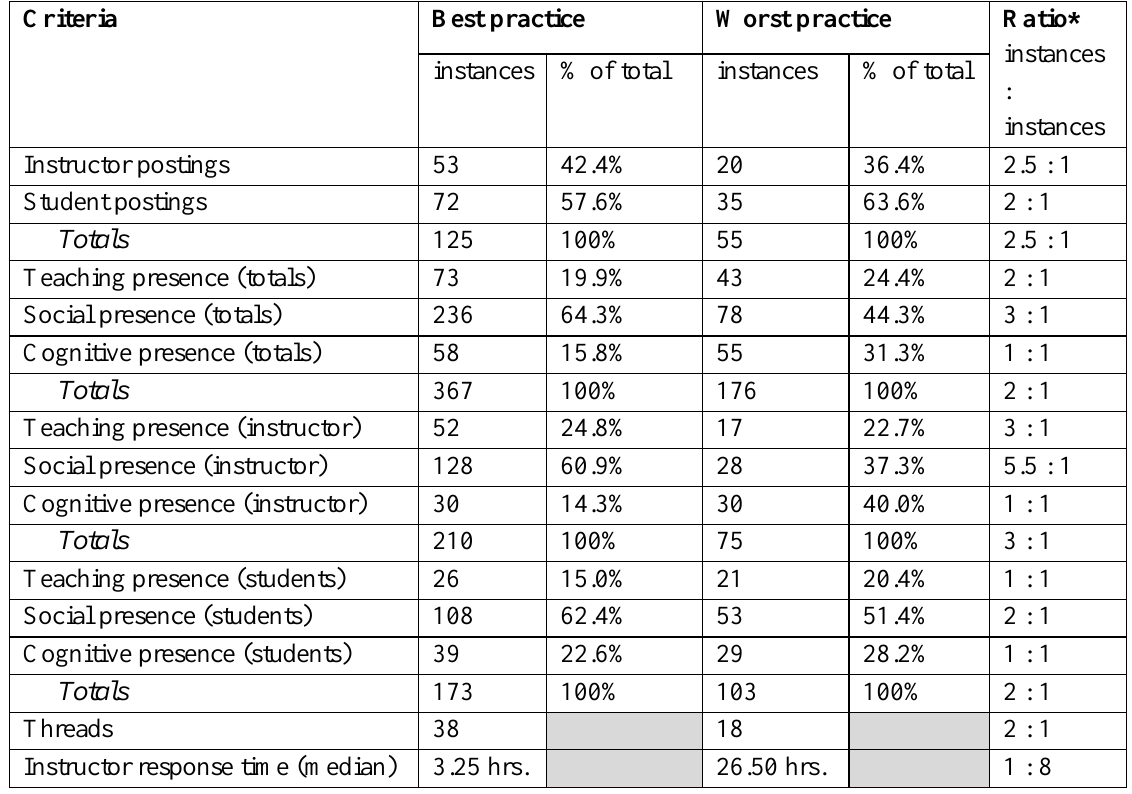
Table 8 Suggestions for Best and Worst